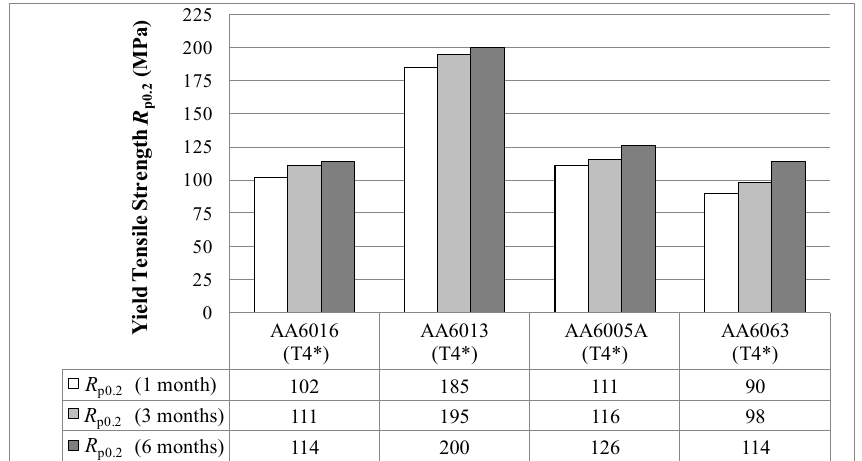
Figure 5. Yield tensile strength R after sheet production (LT-direction).